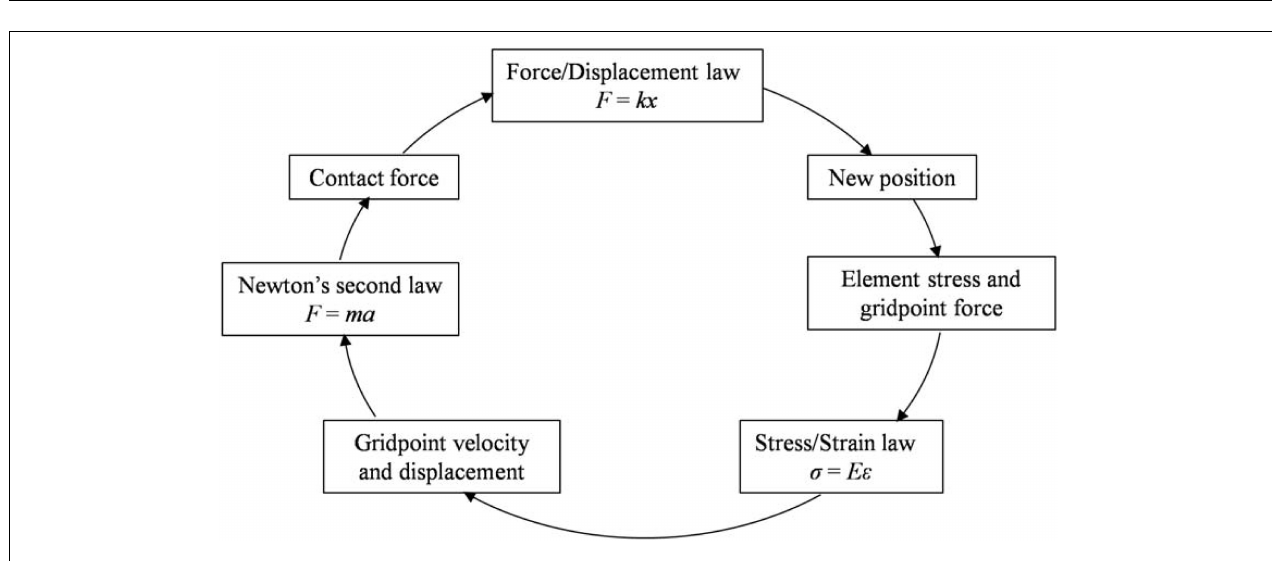
FIGURE 5 | Calculation cycle in the 3DEC (modified after Itasca Consulting Group Inc.,